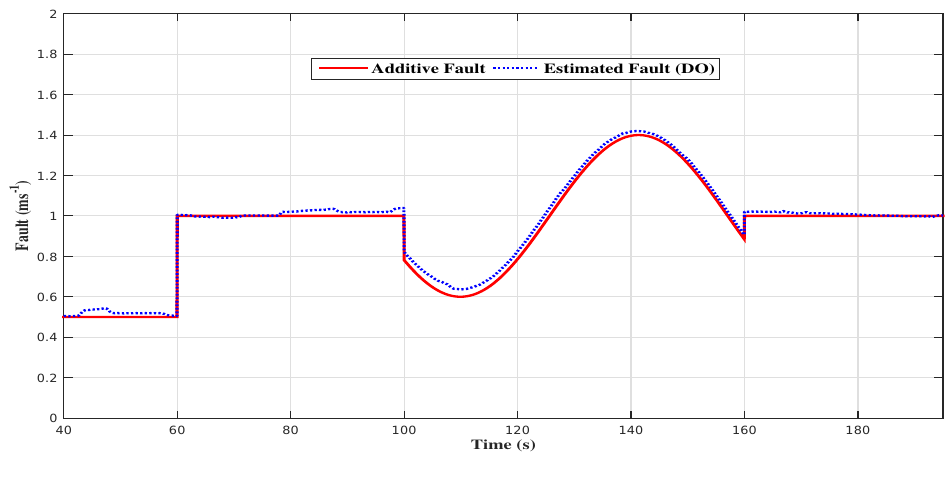
Figure 7. The additive fault with the descriptor observer closed loop FTC.